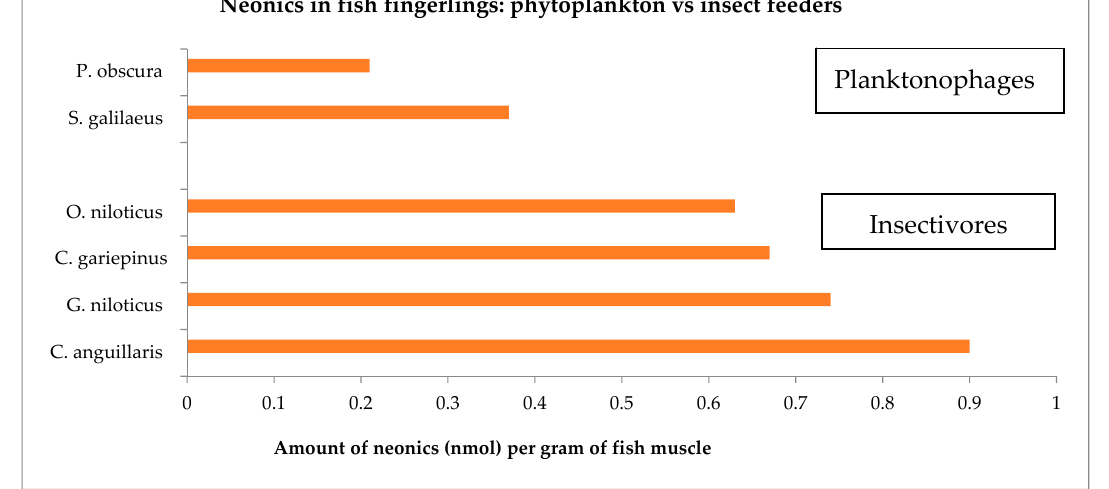
Figure 6. Comparison of neonics content in fish muscle between phytoplankton and insect feeders. Inorganic and organic matter can be adsorbed and desorbed from suspended solids and benthic sediments and the flux is continuous. It is possible that adsorbed surface materials can be desorbed by gastric juices with a range of pH and enters into solution before uptake into the blood stream. Much is known about how a fish ejects sand from itself, but understanding the leaching of neonics in